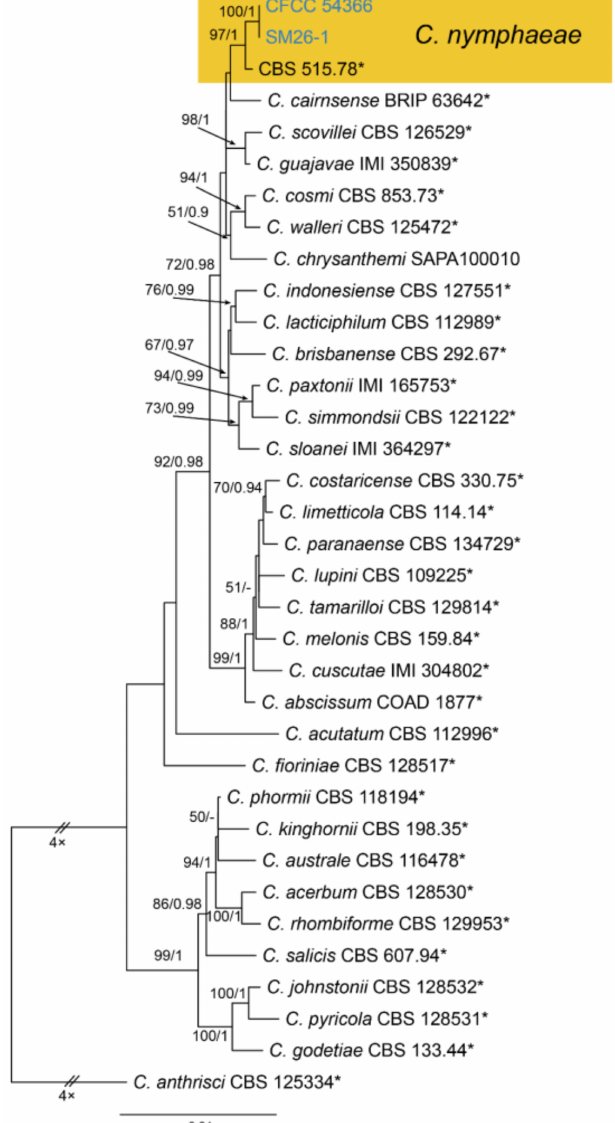
Figure A15. Phylogram generated from RAxML analysis based on combined ITS, act , chs-1 , gapdh and tub2 sequence data of Collectrichum acutatum species complex isolates. The tree was rooted to Collectrichum anthrisci (CBS 125334). The scale bar indicates 0.04 nucleotide changes per site. Isolates from this study are marked in blue, ex-type strains are marked with *, and the identified species is marked in